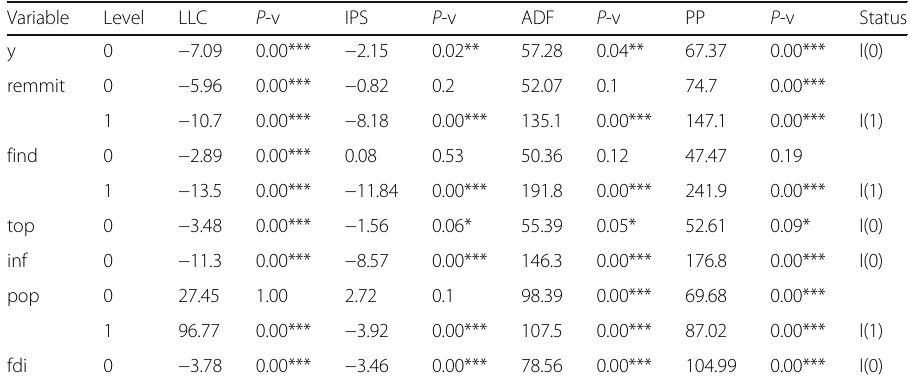
Table 6 Panel Unit Root Results with Individual